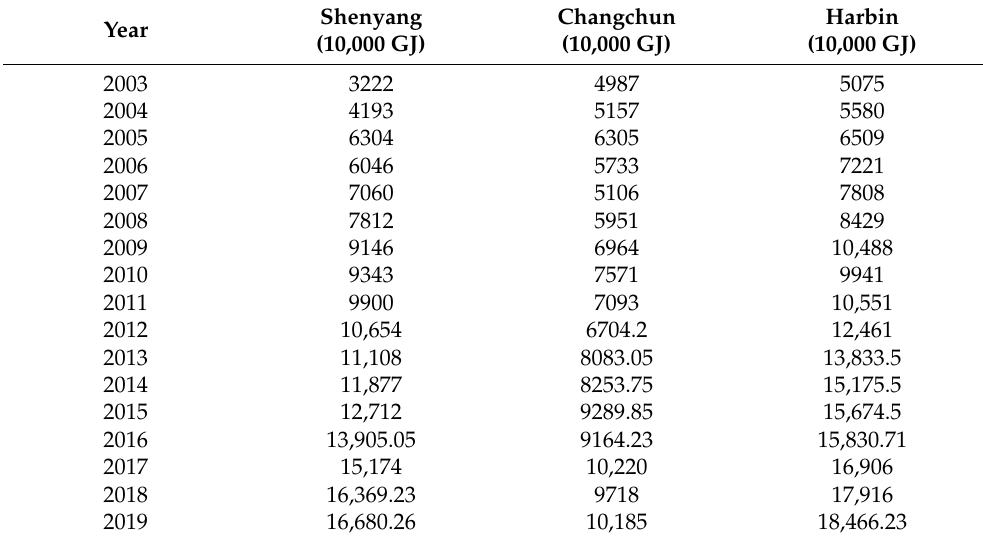
Table 1. Central heating supplies (CHS) in three